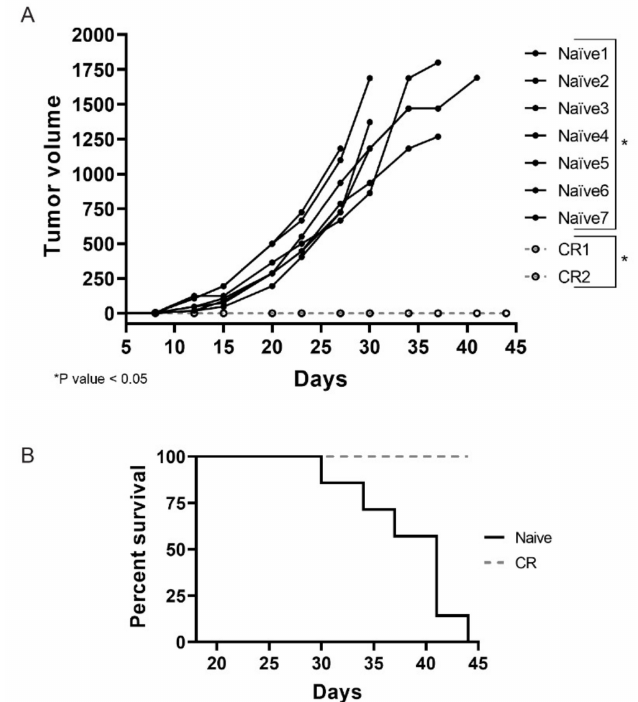
Figure 4. INT230-6 complete responders show immunological memory upon re-challenge. ( A ) The individual tumor growth curves of seven naïve BALB / c mice and the two complete responders (CRs) previously treated with INT230-6, inoculated with 1 × 10 6 Colon-26 tumor cells in the flank opposite to original inoculation. The two groups show statistical di ff erences ( p value < 0.05) calculated with two-way ANOVA on the mean tumor volume of each group. ( B ) Kaplan–Meier curves assessing the survival of mice for 44 days. None of the CR mice showed tumor development for the entire length of the study. No treatment was administered in this